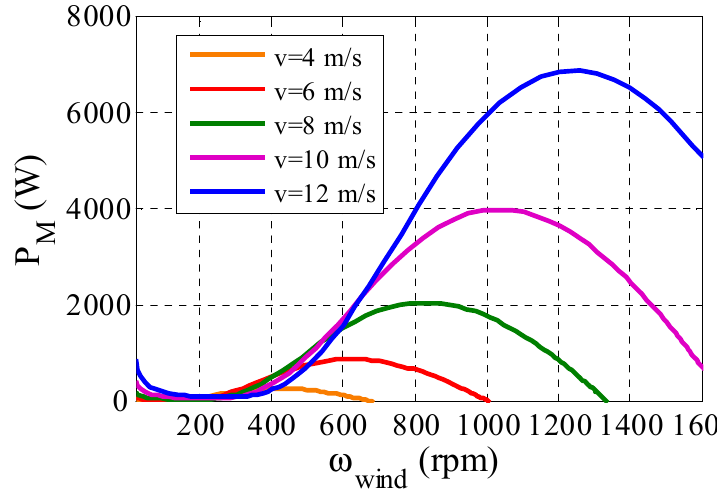
Figure 4. Power – speed characteristics of the wind turbine. Figure 4. Power–speed characteristics of the wind turbine.